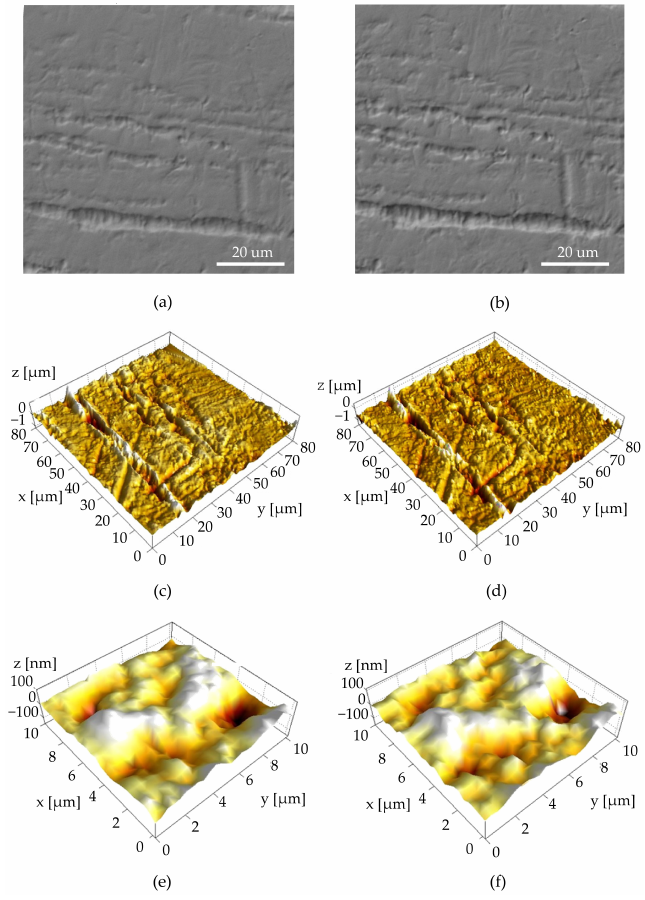
Figure 1 Figure 1. Representative images before (left) and after the corrosion test (right) in Eludril CLASSIC ® (Sample 3): ( a , b ) SEM images of 80 × 80 µ m area; ( c , d ) AFM topography images of the same 80 × 80 µ m area; ( e , f ) AFM topography images of cropped 10 × 10 µ m smooth area between the